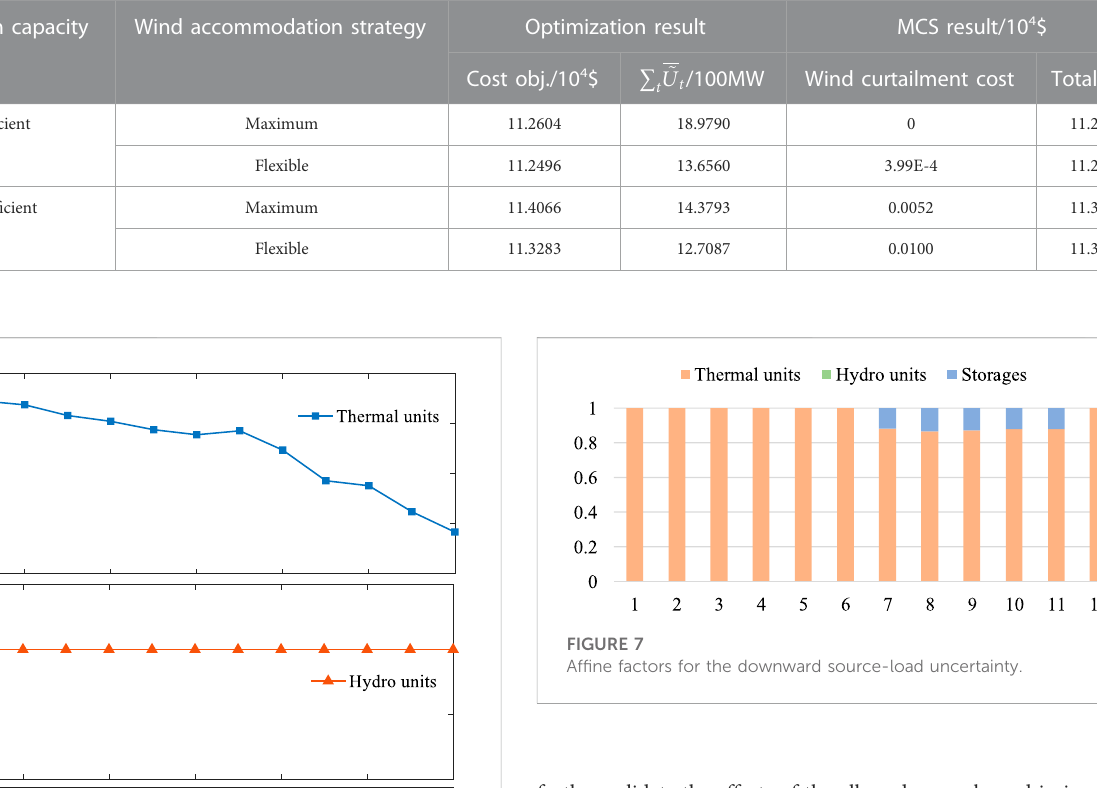
Figure 7 and Figure 8 present the af fi ne factors of thermal units, hydro units, and energy storages for the downward and upward